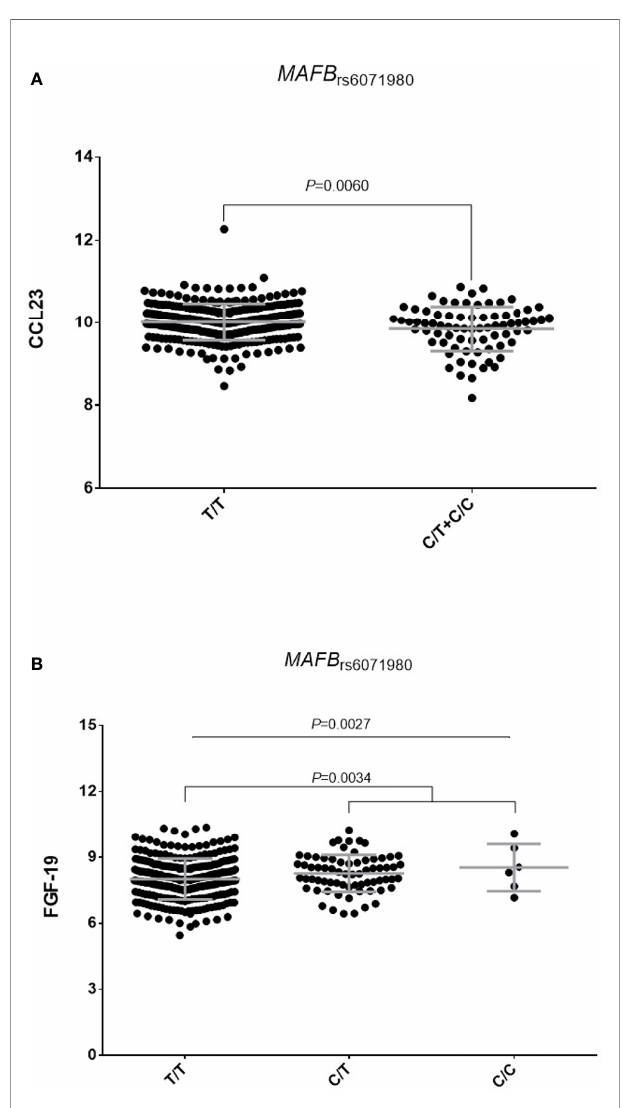
FIGURE 3 | orrelation of the MAFB rs6071980C allele with serum levels of CCL23 (A) and FGF-19 proteins (B)